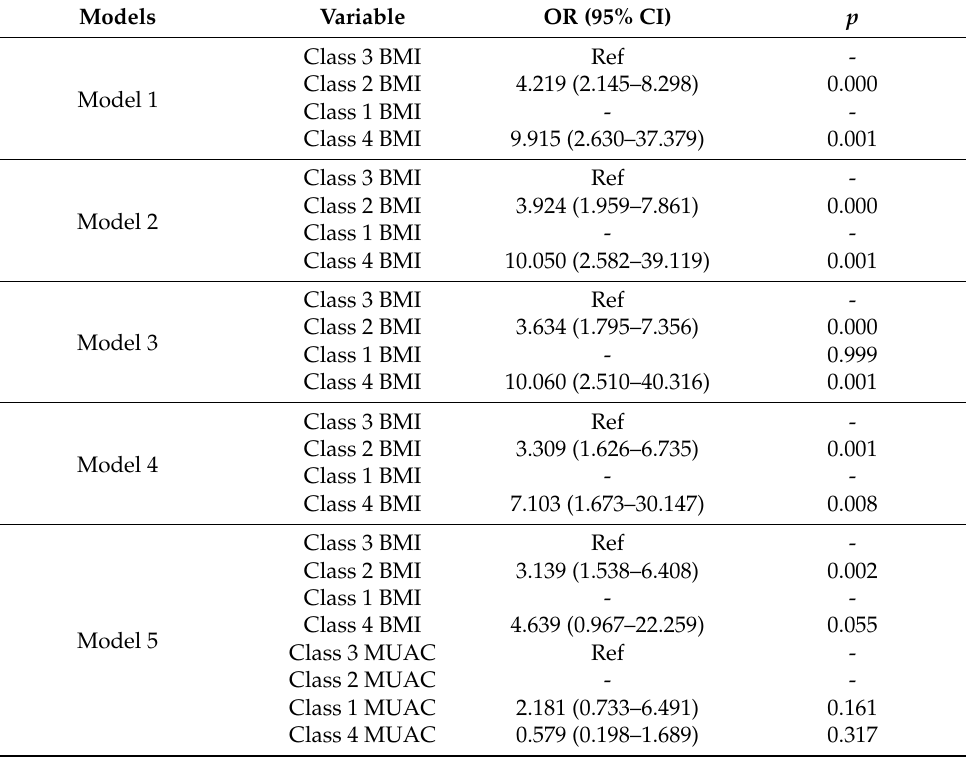
Table 1. The associations between BMI trajectories and diabetes by logistic regressions.